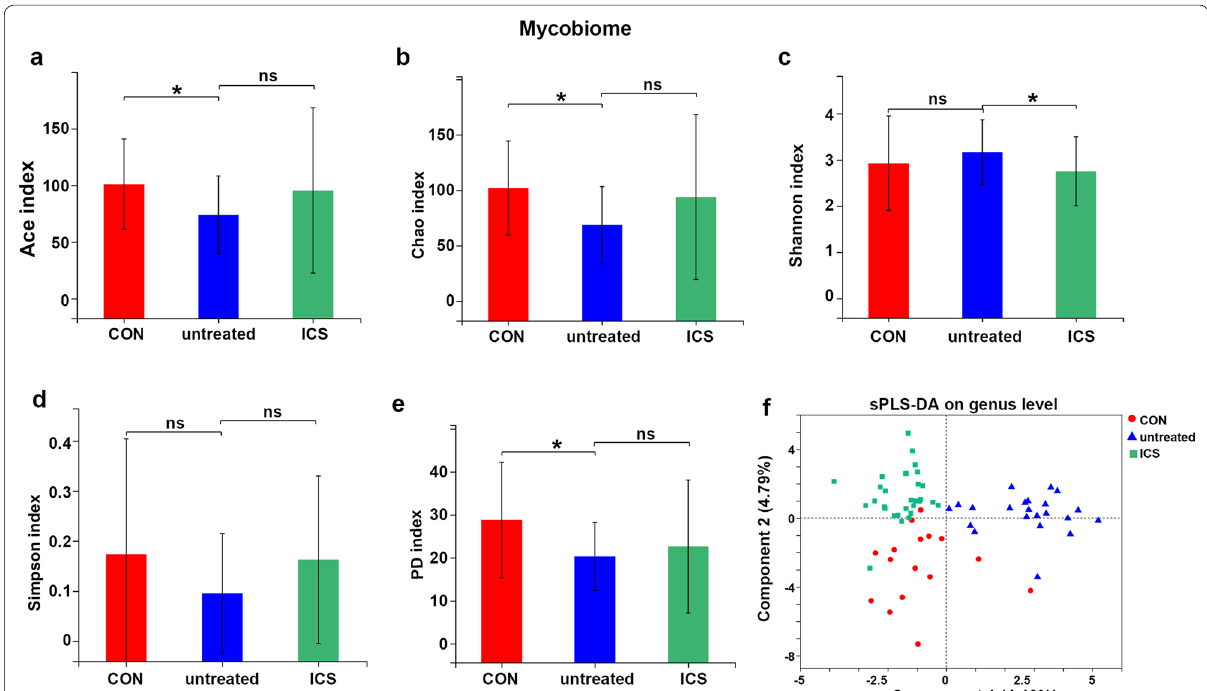
Fig. 1 α and β diversity of the airway mycobiome. a , b Mycobiome richness as indicated by Ace and Chao indices. c – e Shannon, Simpson and PD indices. Statistical significance was determined using Kruskal–Wallis rank-sum test.